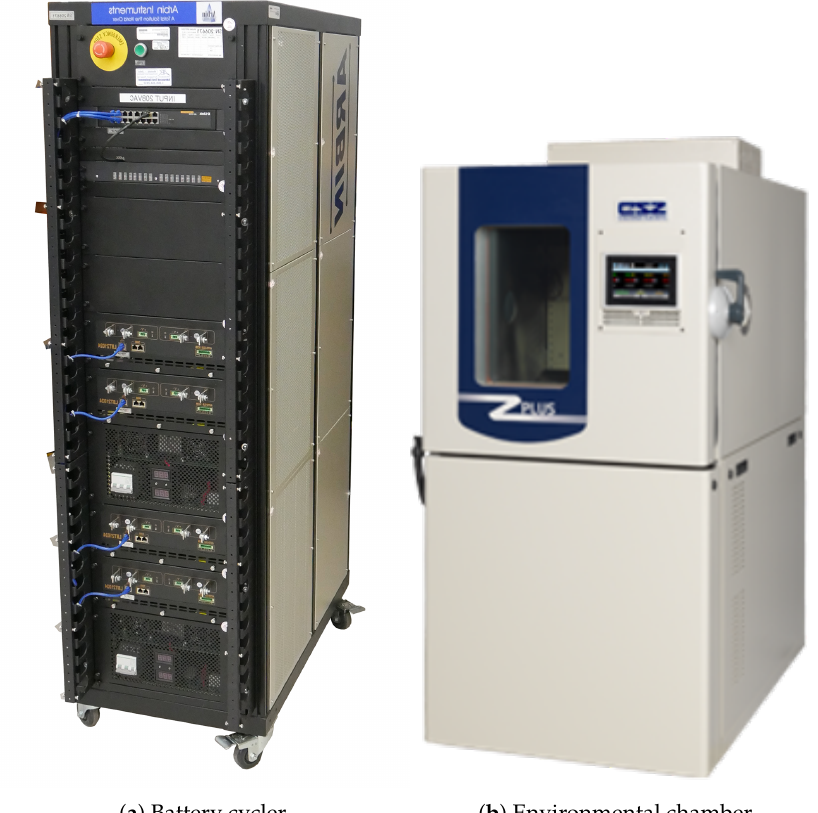
Figure 1. Scientific-grade equipment used to collect OCV characterization